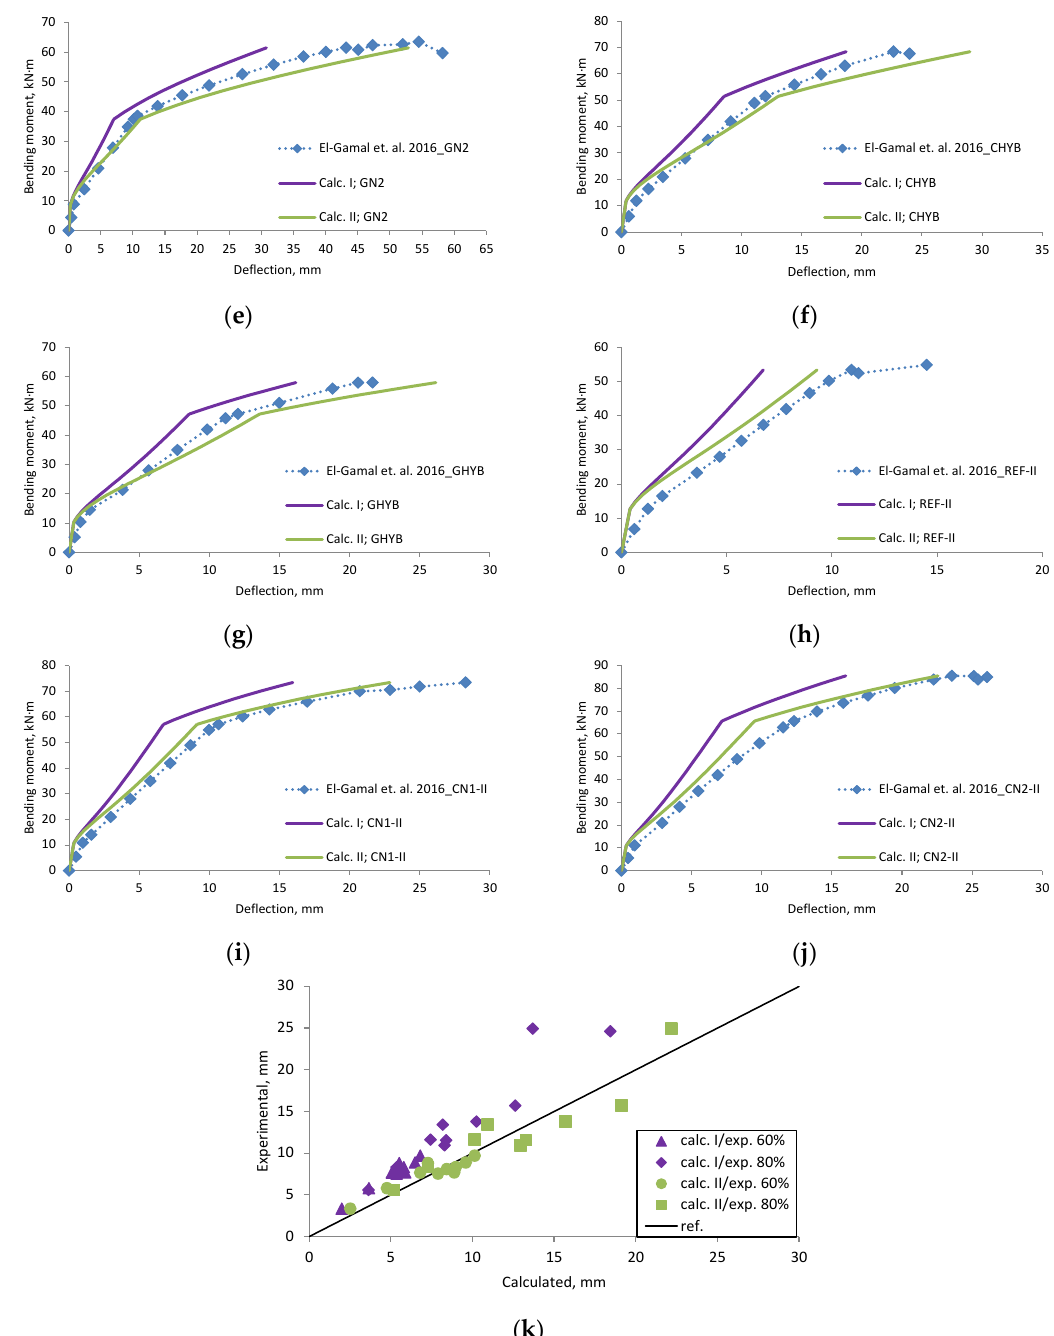
Figure A4. El-Gamal et al., 2016 [27] research beams deflection compared with calculated, ( a ) beam REF; ( b ) beam CN1; ( c ) beam CN2; ( d ) beam GN1; ( e ) beam GN2; ( f ) beam CHYB; ( g ) beam GHYB; ( h ) beam REF-II; ( i ) beam CN1-II; ( j ) beam CN2-II; ( k ) scatter of the results at 60% and 80% of the ultimate load.